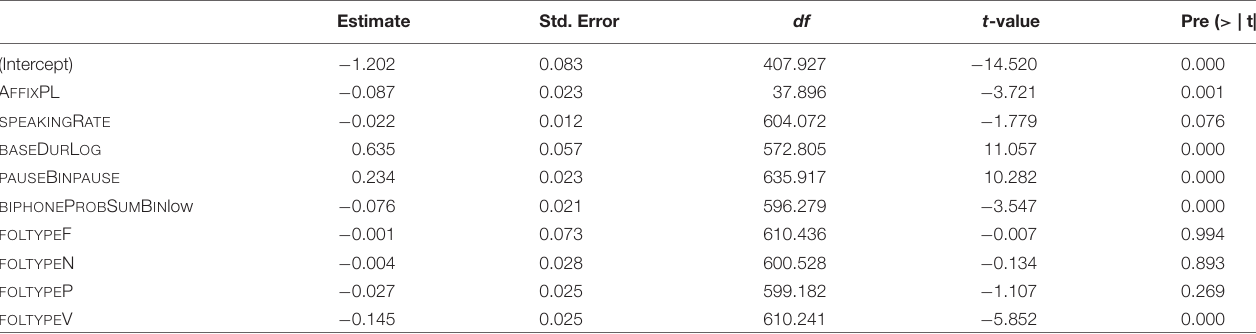
TABLE 5 | Fixed-effect coefficients and p -values as computed by the final “traditional” model (mixed-effects model fitted to the log-transformed duration of S). Estimate Std. Error df